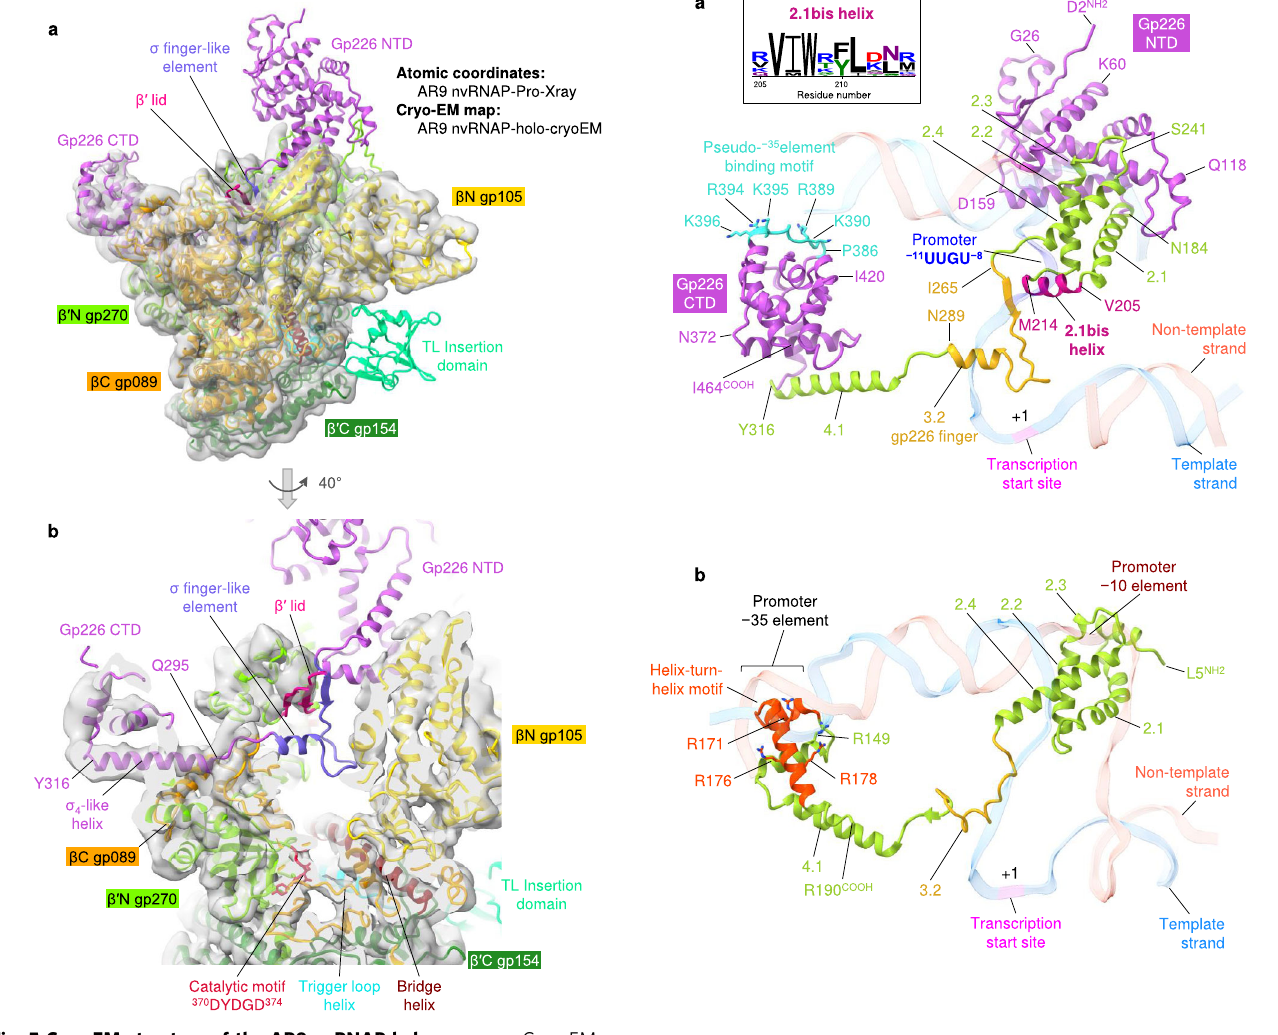
gp226 is in line with that of bacterial σ factors.